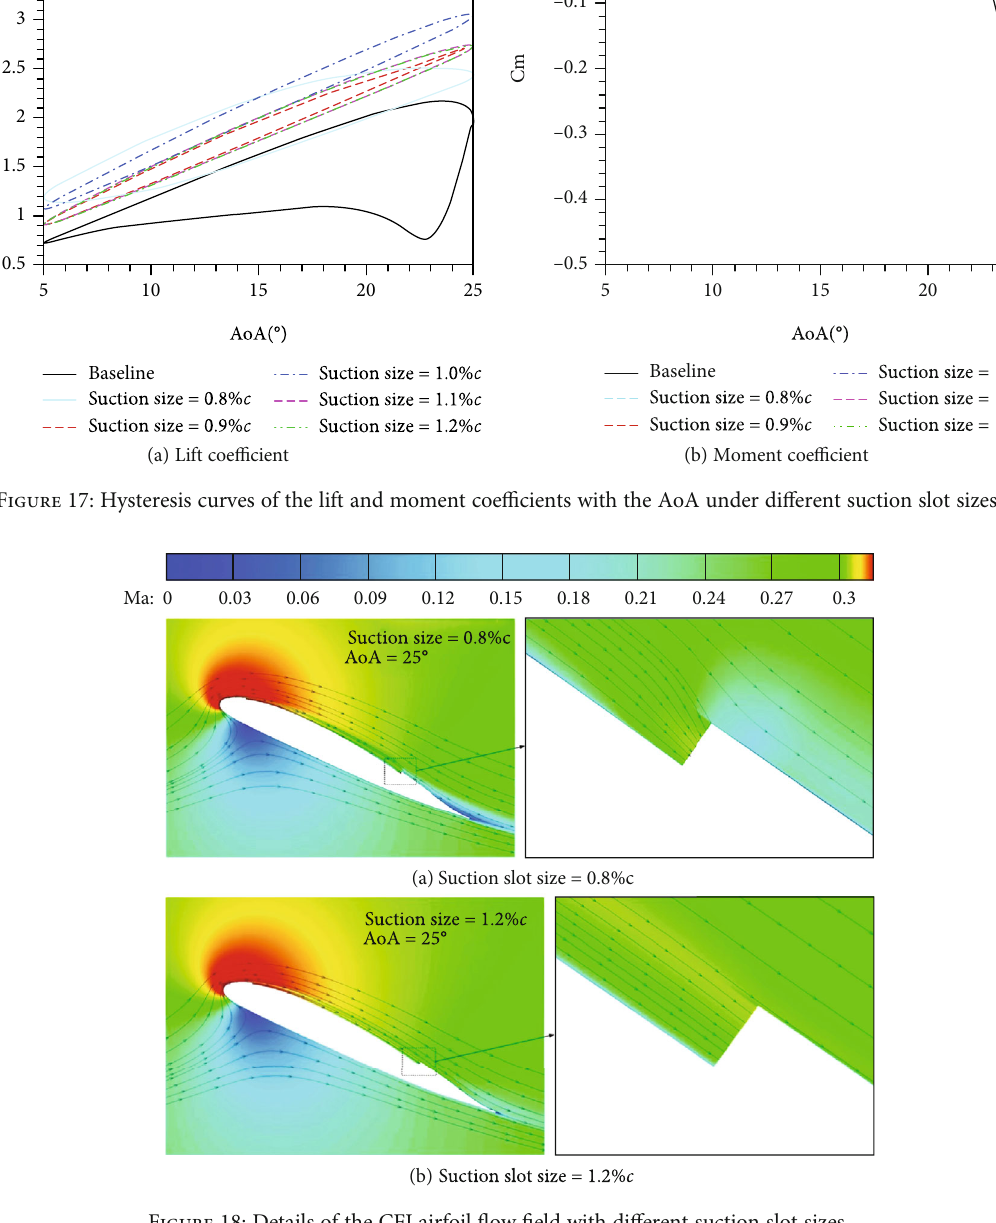
Figure 18: Details of the CFJ airfoil fl ow fi eld with di ff erent suction slot